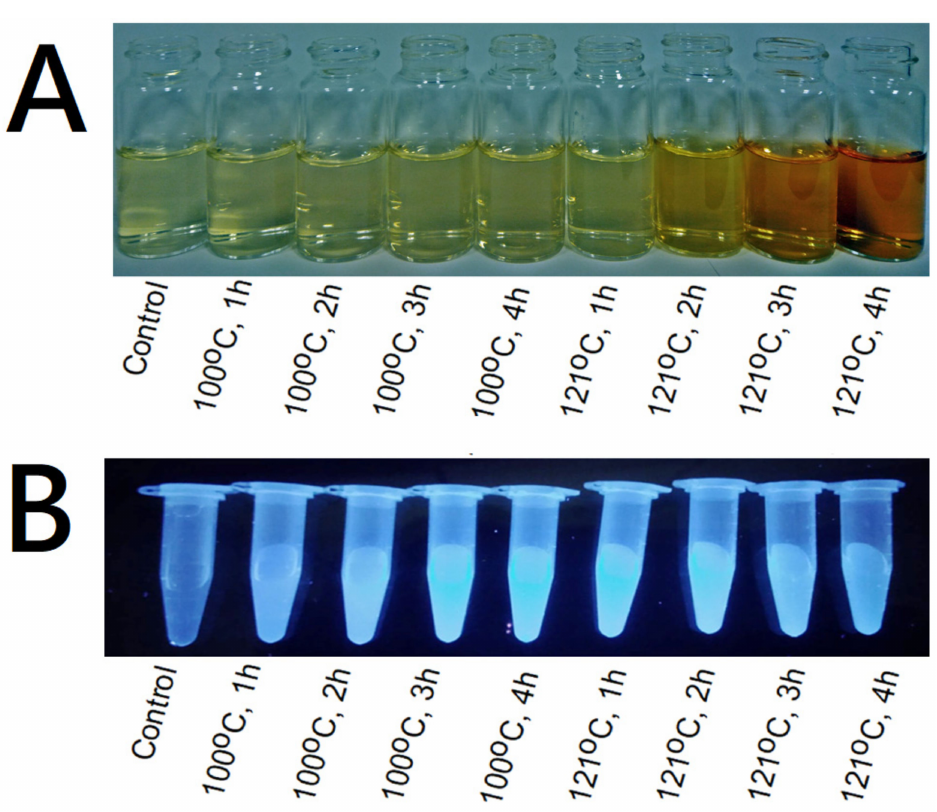
Figure2. PhotographofWSCandWSCGDsundernaturallight( A )andultravioletlight( B ).Allsolutions had the same concentration of 1 mg /